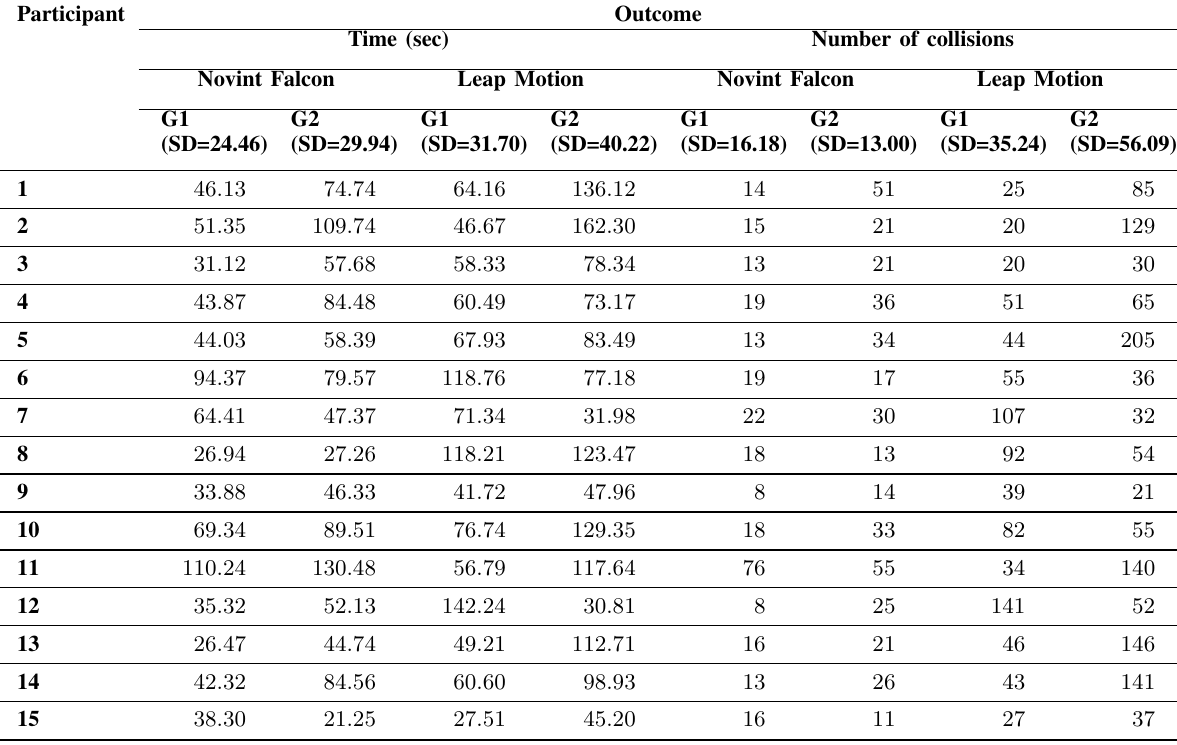
TABLE II E VALUATION RESULTS OF THE EXERCISE IN TERMS OF PERFORMANCE ( TASK EXECUTION TIME AND NUMBER OF COLLISIONS ). G1: GROUP OF HEALTHY ADULTS , G2: GROUP OF ELDERLY WITH HAND MOTOR IMPAIRMENTS . SD: S TANDARD D EVIATION .